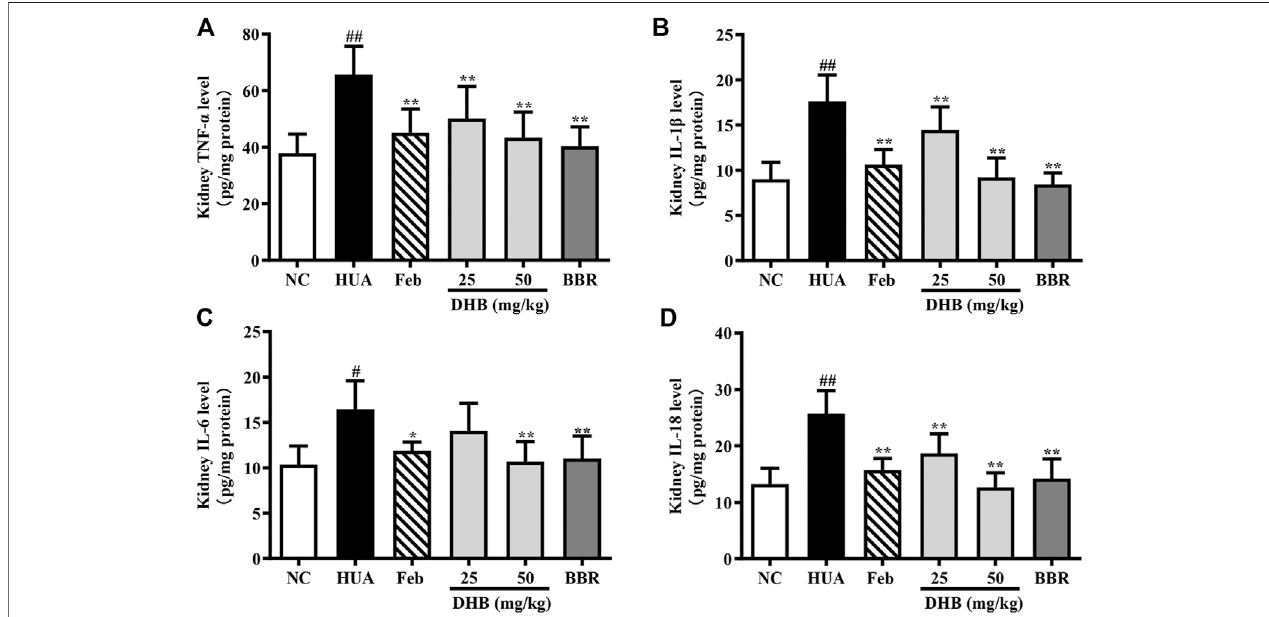
FIGURE 6 | Effect of DHB on kidney in fl ammation cytokines levels in PO/HX-induced hyperuricemic mice by ELISA. (A) TNF- α (B) IL-1 β , (C) IL-6, (D) IL-18. The results are expressed as mean ± SD (n (cid:2) 3 – 5). # p < 0.05, ## p < 0.01, compared with NC group; *p < 0.05, **p < 0.01, compared with HUA group.